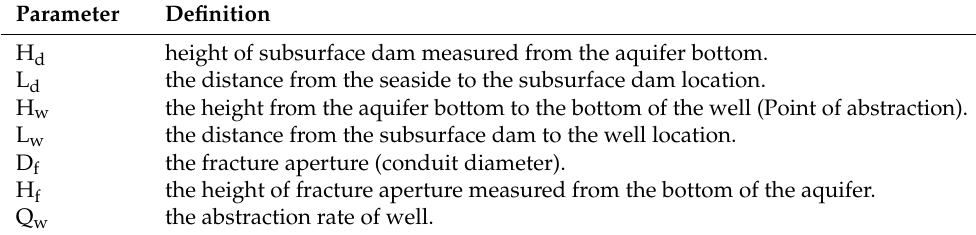
Table A1. Parameter definitions used for numerical